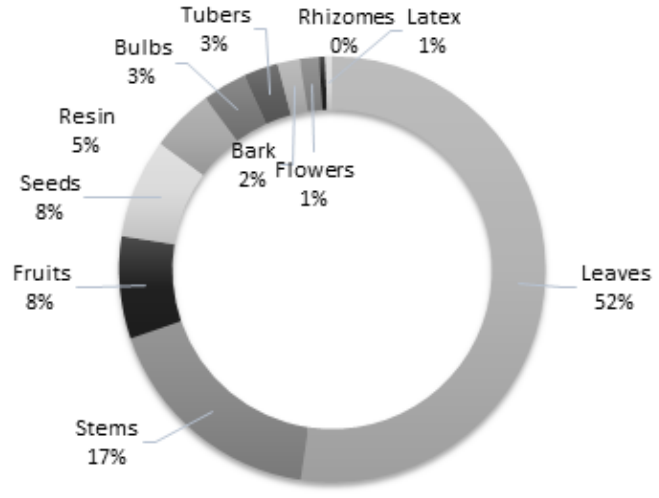
Figure 3. Relative importance of different plant parts used for medicinal